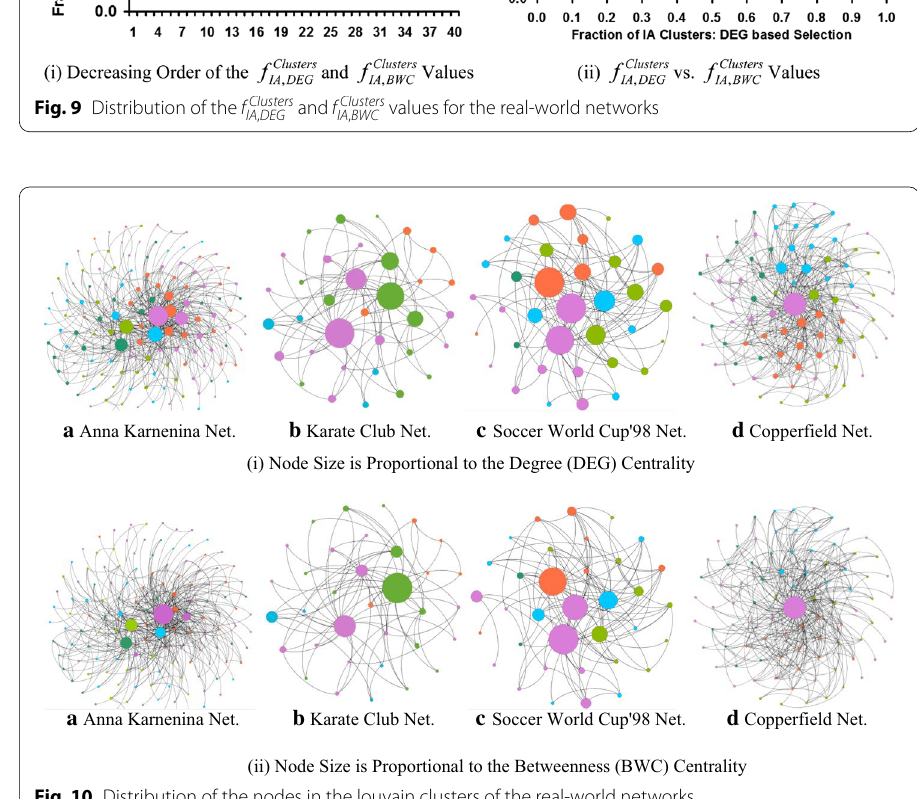
Fig. 10 Distribution of the nodes in the louvain clusters of the real-world